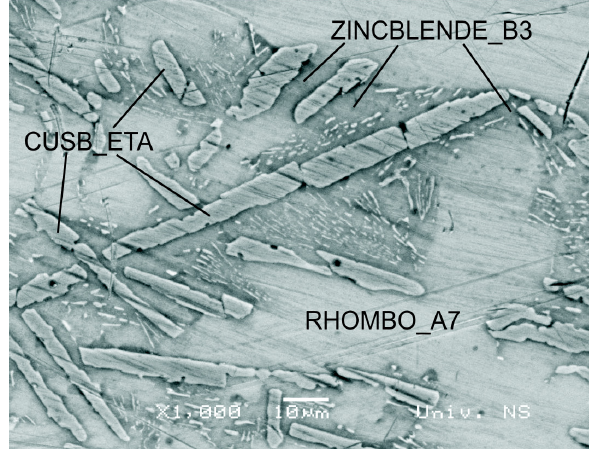
Figure 4. SEM-microstructure